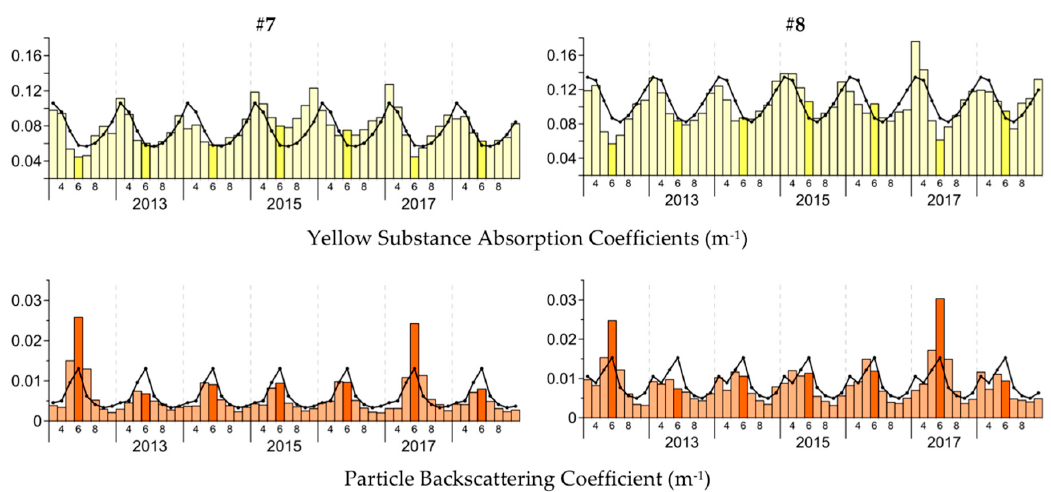
Figure 2. Variability of the monthly mean values of the yellow substance absorption coefficients a g and the particle backscattering coefficients b bp in the eastern open part (sub-region #7) and in the eastern and southern shelf areas (sub-region #8) of the Black Sea in 2012–2018. The black lines show the seasonal variability of the climatic values, which are averaged values over the period of 1998– 2011.